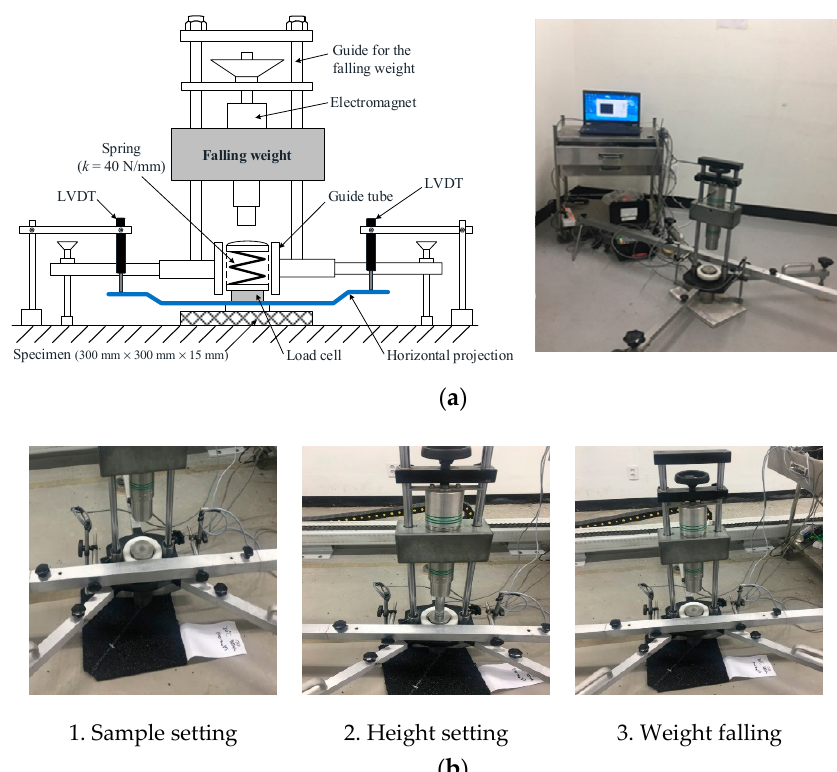
Figure 5. Vertical deformation test equipment and procedure: ( a ) Artificial athlete apparatus used for the vertical deformation test, and ( b ) the vertical deformation test procedure. LVDT: linear variable differential transducer.